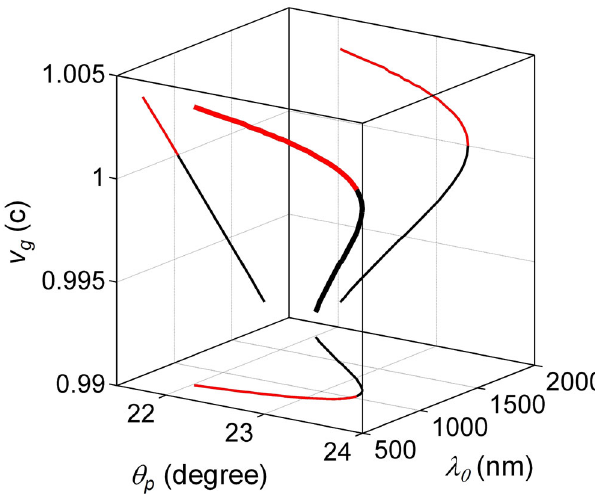
Fig. 2 Relationship between vertex wavelength and velocity of space- time (ST) wave packet with pump angle of collinear optical parametric ampli fi cation. When the collinear phase-matching is satis fi ed (515 nm pumped type-I BBO crystal here), each pump angle θ p corresponds to two (vertex) wavelengths λ 0 (red and black), and the (vertex) wavelength λ 0 that is shorter (red) and longer (black) than the degenerate-wavelength (1030 nm here) corresponds to a ST wave packet with a superluminal (red) and a subluminal (black) velocity v g ,